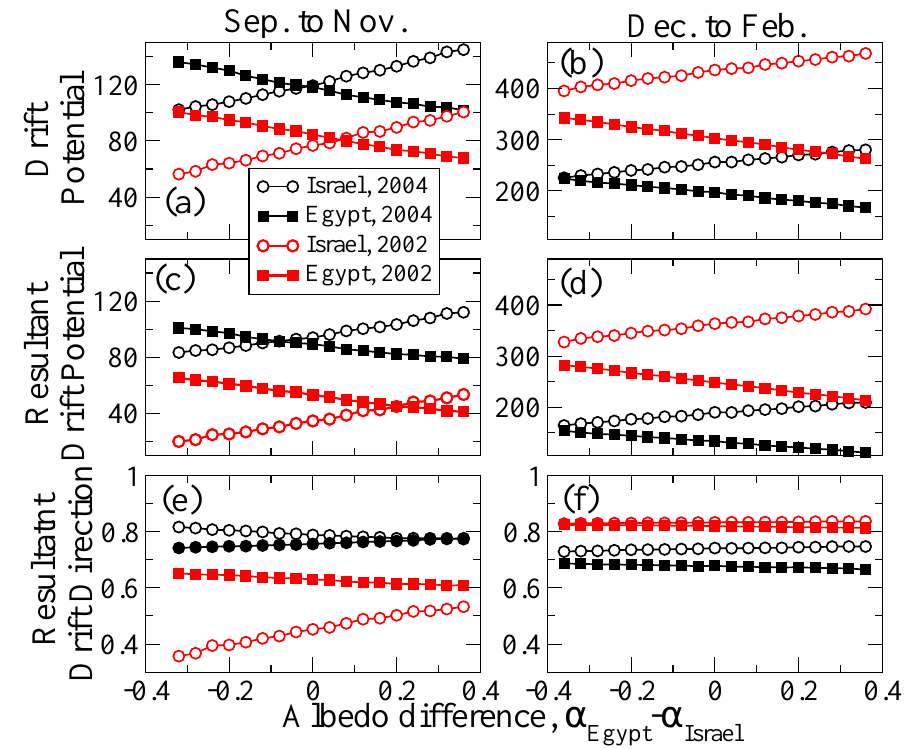
Figure 4. Same as Fig. 3 for the (a,b) wind drift potential (DP), (c,d) resultant drift potential (RDP), and (e,f) resultant drift direction (RDD).